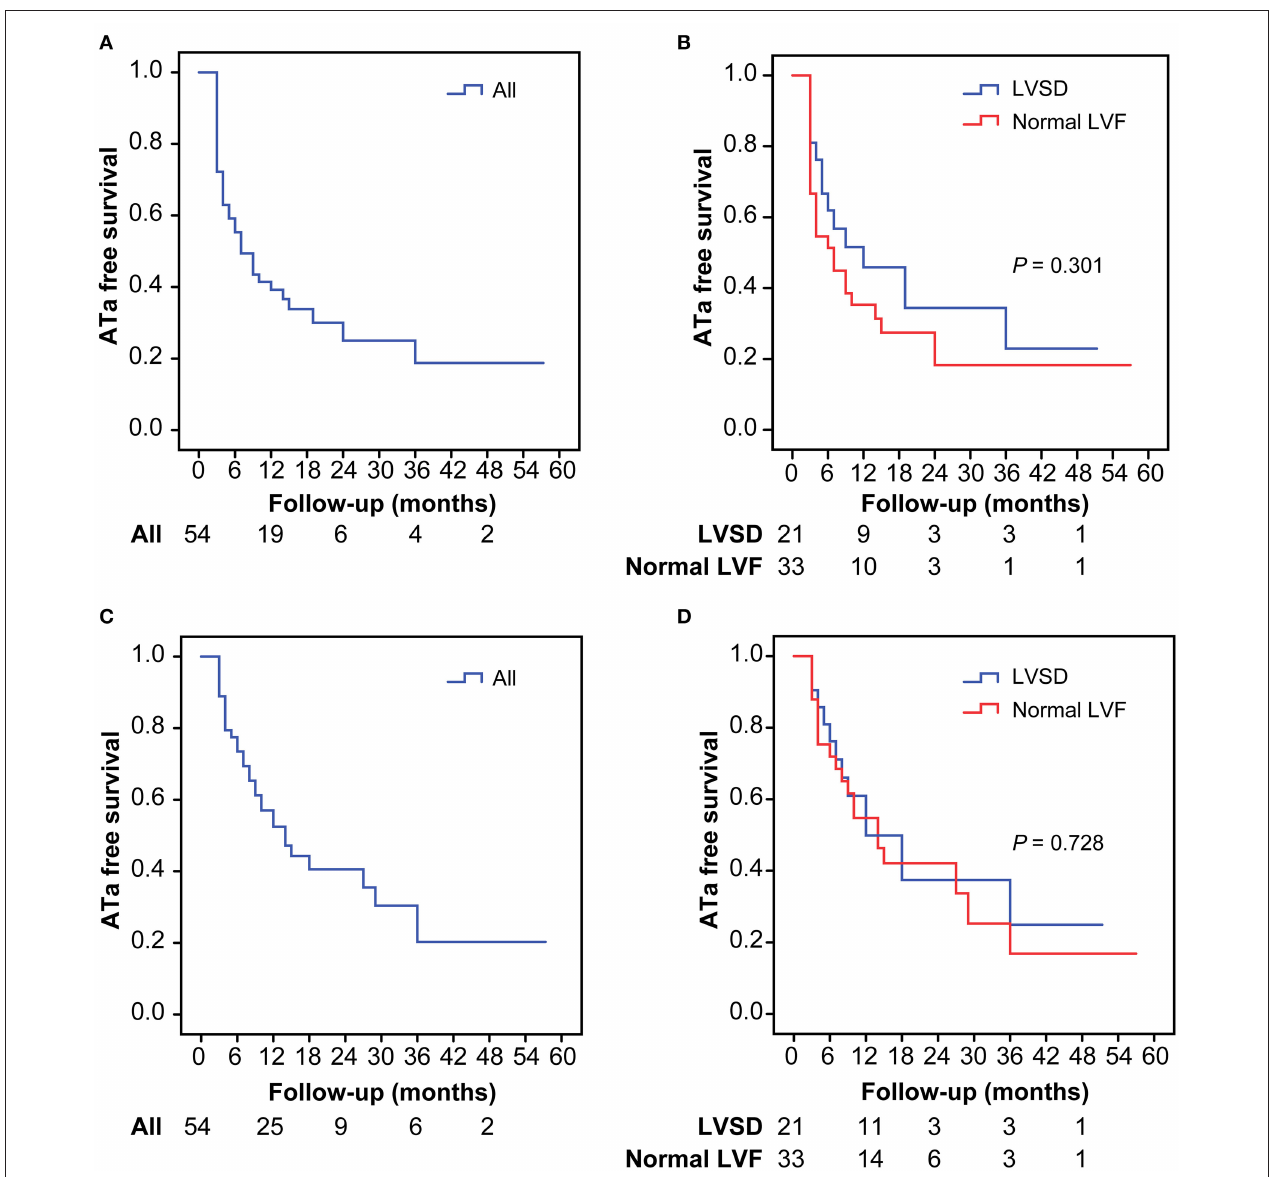
FIGURE 1 | Kaplan–Meier analysis for atrial tachyarrhythmia-free survival after the first procedures in the overall population (A) and in patients with LVSD and normal LVF (B) , after multiple procedures in the overall population (C) , and in patients with LVSD and normal LVF (D) . ATa, atrial tachyarrhythmia; LVSD, left ventricular systolic dysfunction; LVF, left ventricular